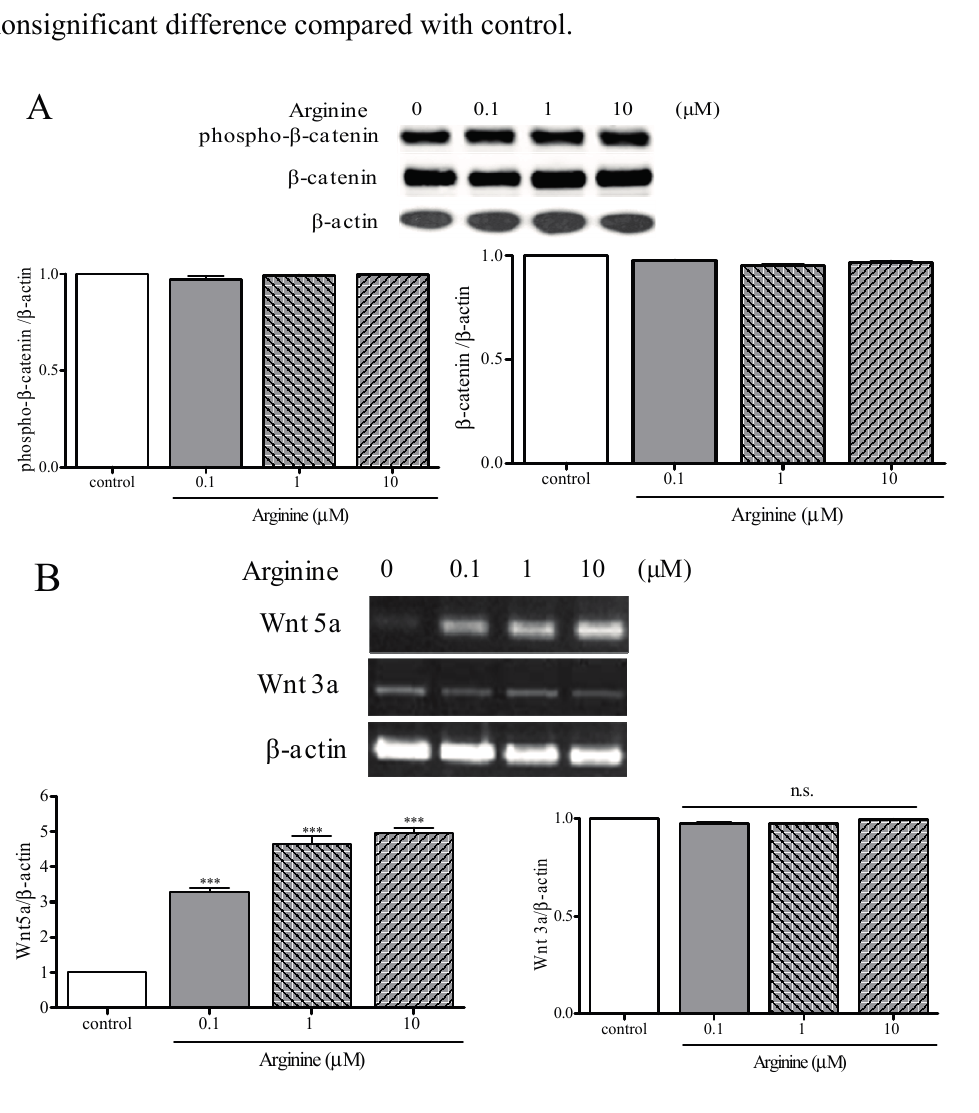
effect of arginine, MSCs treated with 1 μ M arginine in the presence of Dickkopf-1 (DKK-1) and secreted Frizzled-related protein-1(sFRP-1), which are recognized inhibitors of Wnt signaling. Addition of DKK1 or sFRP1 abolished arginine induced modulation of Runx2 and PPAR γ 2 expression in MSCs (Figure 5A,B), which indicates that Wnt signaling partially contributes to the arginine dependent induction of osteoblastogenesis and reduction of adipogenesis in MSCs. Figure 4. Effect of arginine on the expression of Wnt signaling pathway. ( A ) The representative Western blot analysis for phospho- β -catenin and β -catenin in total protein extracts from MSCs treated indicated dose of arginine for 24 h. The bar graph showed the intensities of phospho- β -catenin and β -catenin expression; ( B ) MSCs were treated with 0, 0.1, 1, and 10 μ M arginine for 24 h and then total RNA was isolated and analyzed for Wnt5a, Wnt3a, and β -actin by performing RT-PCR. The bar graphs show the band intensities of Wnt5a and Wnt3a after adjustment for the intensity of β -actin; ( C ) The expression level of NFATc1 was measured using Western blot analysis, and normalized relative to the level of β -actin. Values are mean ± S.E.M. *** p < 0.001 compared with control; n.s., nonsignificant difference compared with control.